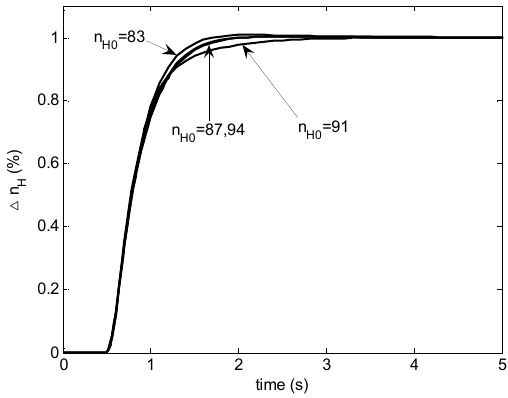
Figure 13. Polynomial fitted result of ∂ x k 1 e ( α ) / ∂α and ∂ u ke ( α ) / ∂α .